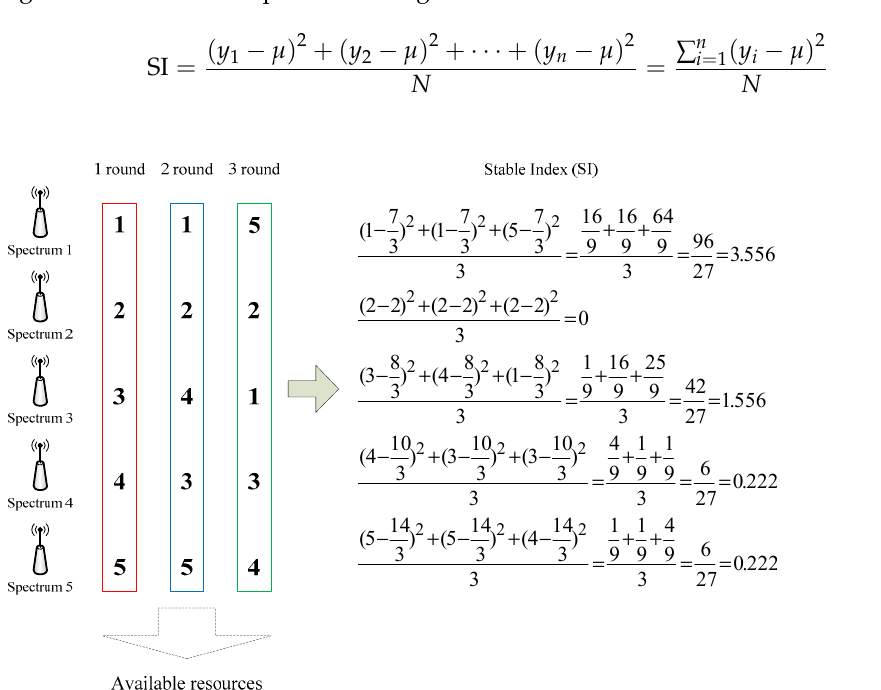
Figure 7. Cooperation-assisted with fast scan mechanism.